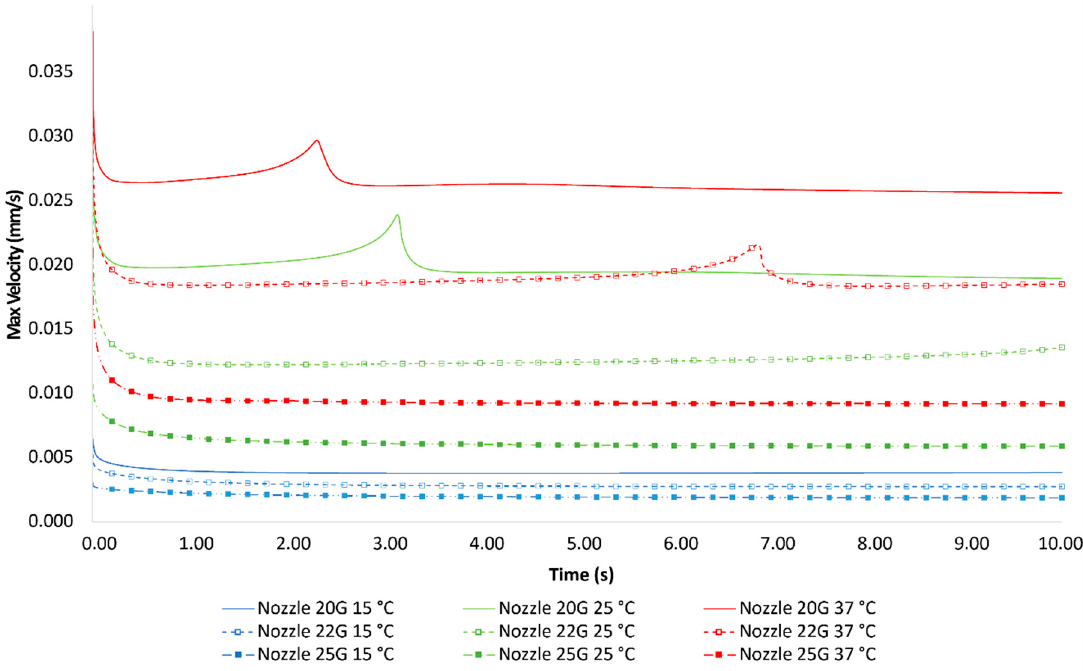
Figure 7. Maximum outlet velocity of 20G, 22G, and 25G conical tips using Cellink Bioink at 15, 25, and 37 °C.